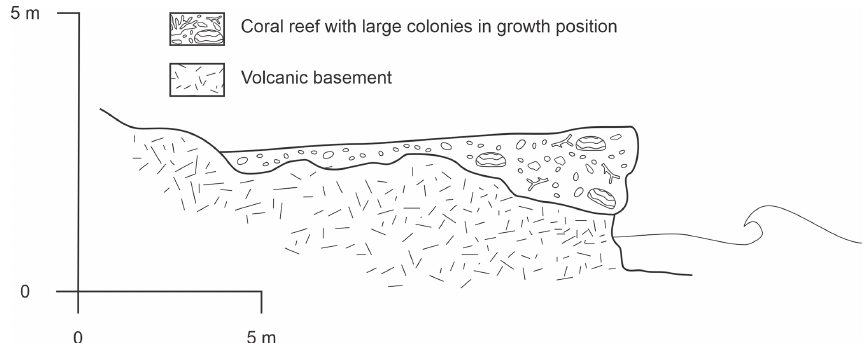
Figure 8. Raised reef platform of Île Plate (modified after Montaggioni, 1982).